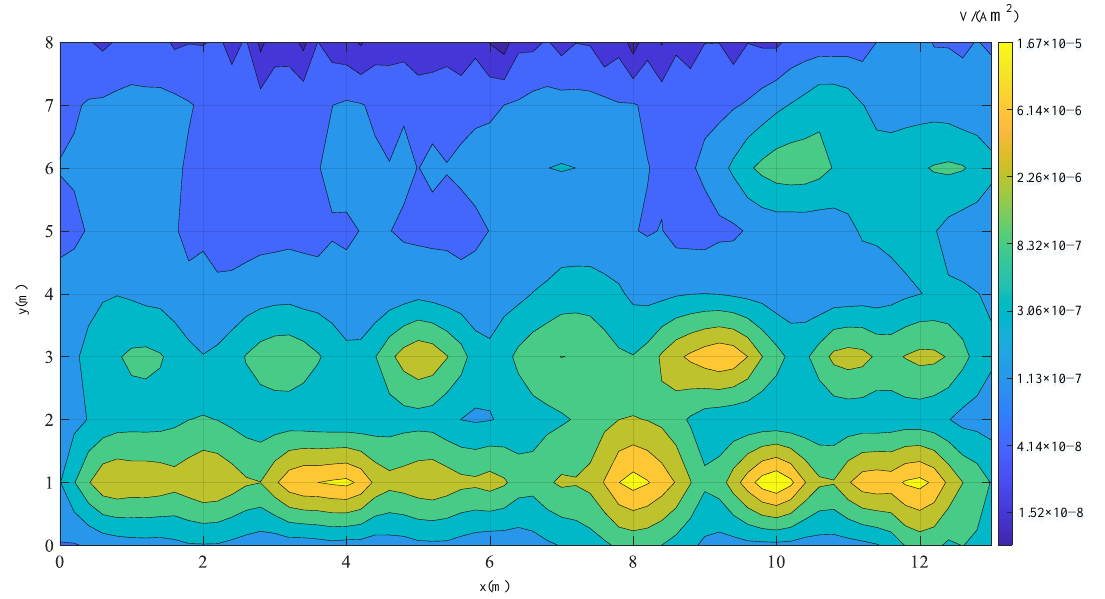
Figure 10. Normalized z component response of the receiving coil R5.